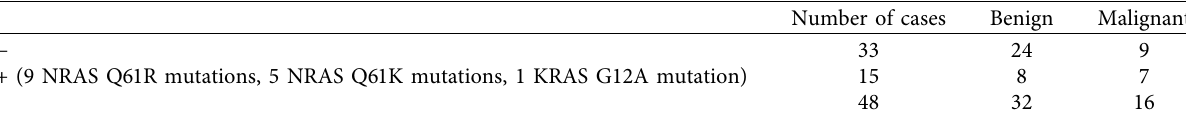
Table 4: RAS status in TIR3